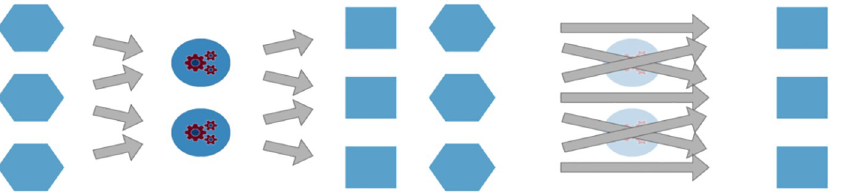
Fig 1. Relationship between countries, capabilities, and products. Left: Capabilities mediate between countries and their export baskets Right: Since capabilities are not observable, their role must be inferred from the bipartite network connecting countries to